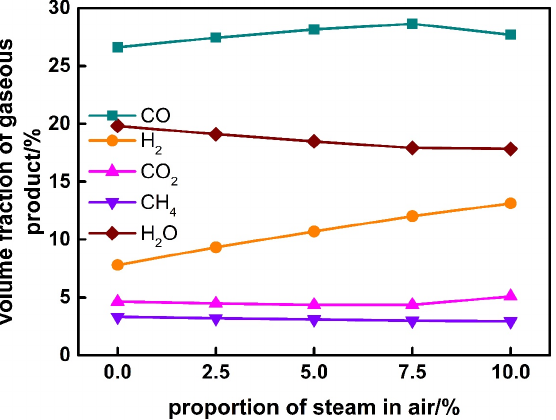
Figure 11. Effect of steam proportion in air on gaseous product.